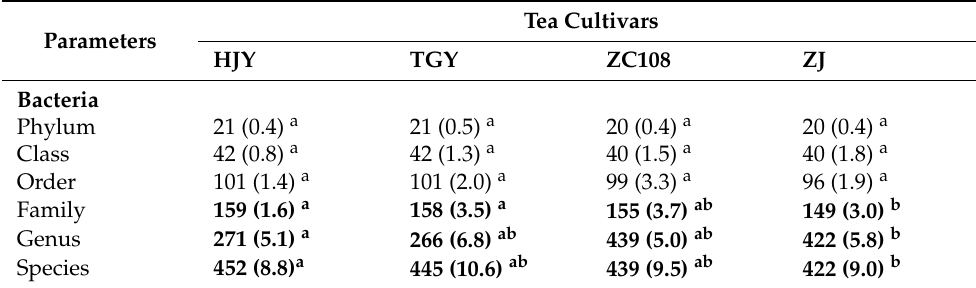
Figure 3. Principal coordinate analysis (PCoA) of bacterial (A, left panel) and fungal (B, right panel) community composition at the OTU level based on Bray–Curtis distances. The percentage variations explained by PCoA1 and PCoA2 are shown along the axes. A permutational multivariate analysis of variance (PERMANOVA) was used to determine the significant effect of the tea cultivars. Table 2. The number, richness, and diversity of bacterial and fungal OTUs (97% similarity level) in soils with four different tea